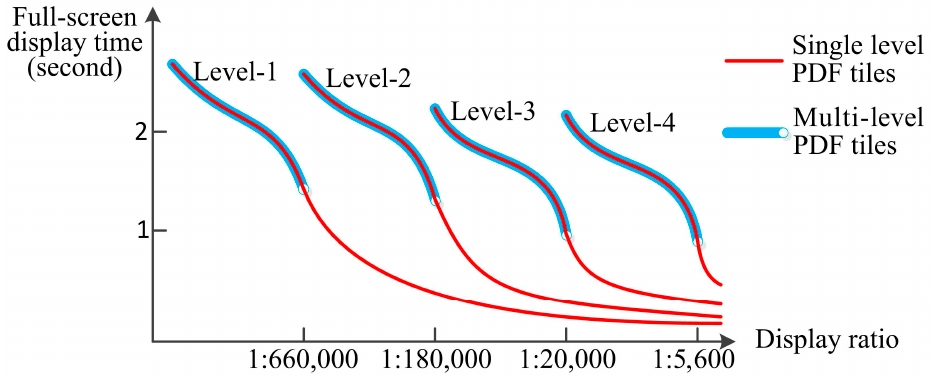
Figure 16. Time curve of the PDF tile map zooming process.